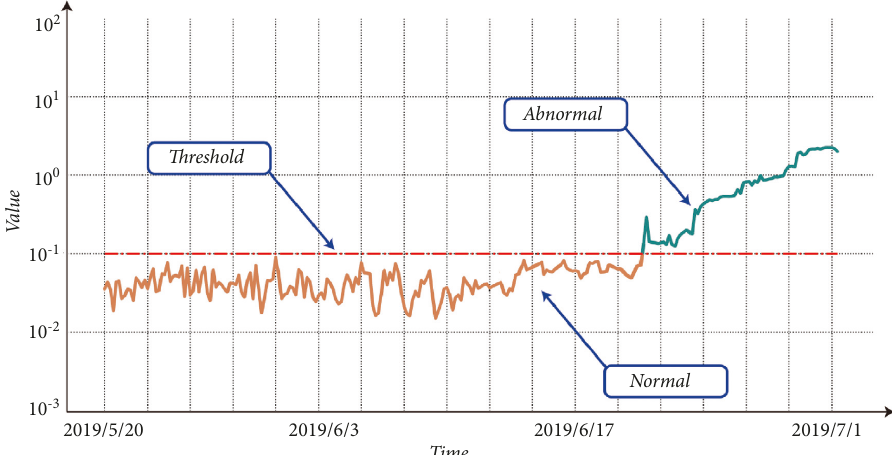
Figure 10: Detection of pump damage time of well 831352627 by DAE.